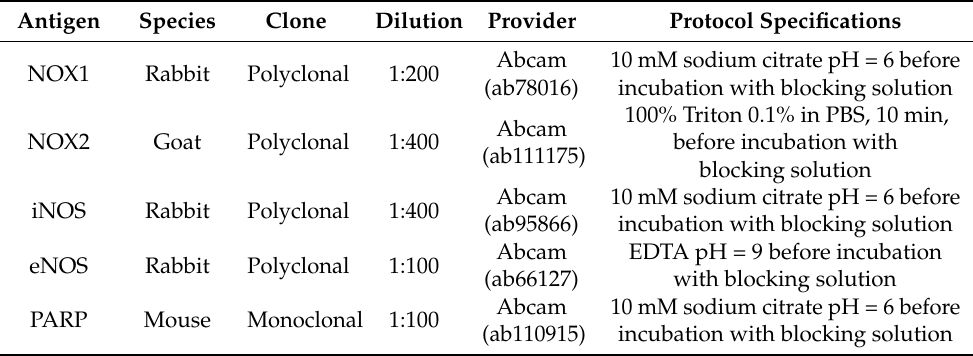
Table 1. Primary antibodies used, together with the dilutions and specifications of the